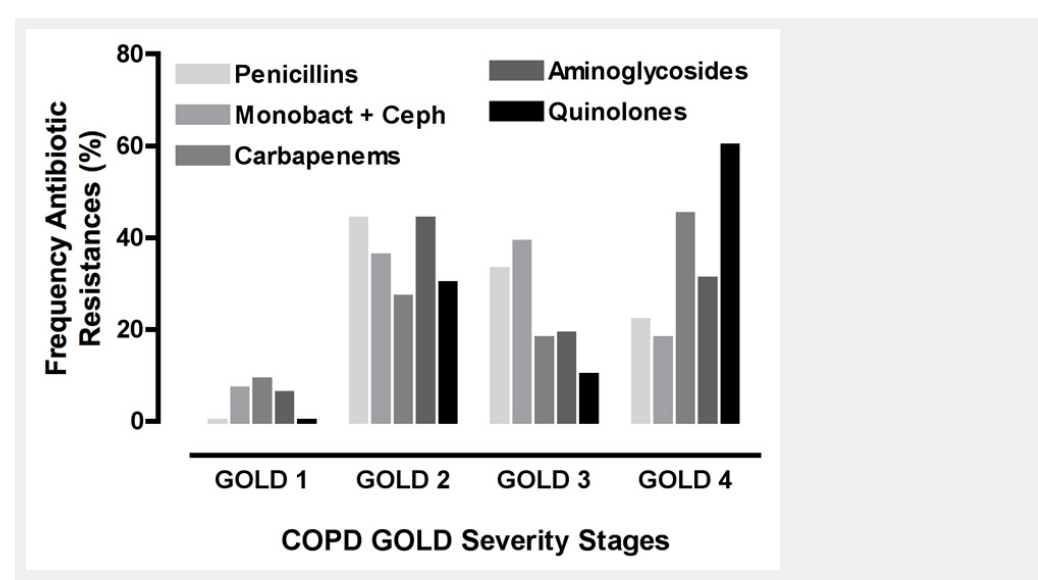
Figure 6 Frequency of resistances against anti-pseudomonas antibiotic classes in different COPD stages (GOLD 1-4) for patients colonised with P. aeruginosa (n = 112). Anti-pseudomonas antibiotic groups: Penicillins, extended spectrum penicillins (Ticarcillin, Ticarcillin/Clavulanic acid, Piperacillin, Piperacillin /Tazobactam), Monobact + Ceph, monobactams and cephalosporins, (Ceftazidim, Cefepime, Aztreonam), carbapenems (Imipenem, Meropenem), aminoglycosides (Gentamicin, Amikacin, Netilmicin, Tobramycin), and quinolones, fluoroquinolones